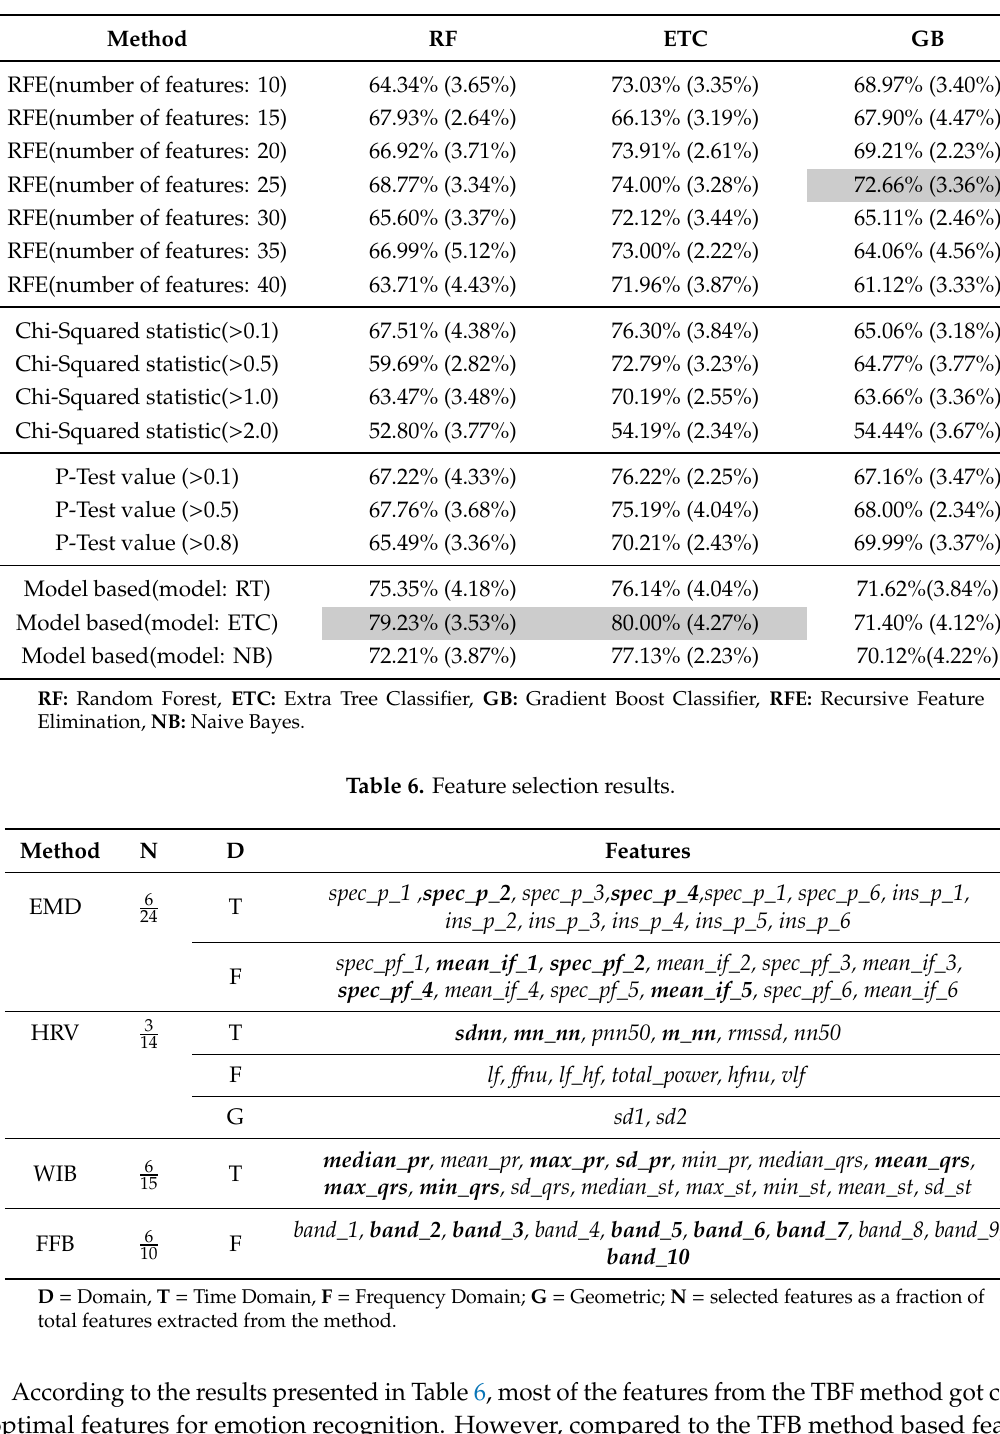
Table 5. Ensemble methods with feature selection.